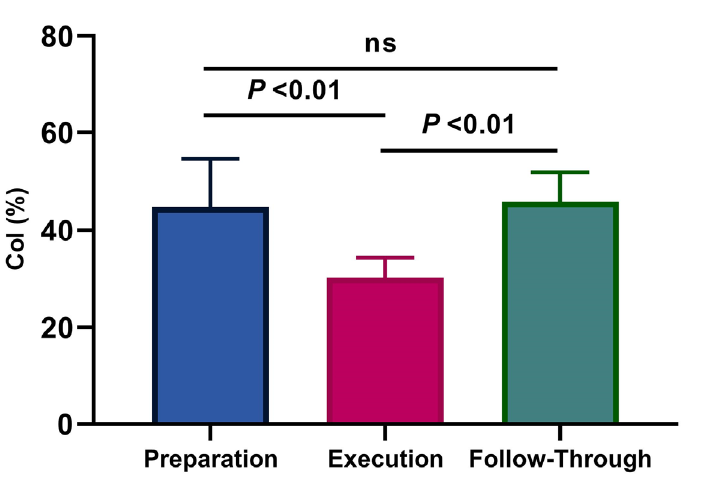
Figure 4. Average values and standard deviations for the co-activation index (CoI) (%) per phase ( η 2 p = 0.73). The agonist/antagonist muscle of each phase was BB/TB, TB/BB, and TB/BB, respec- tively.